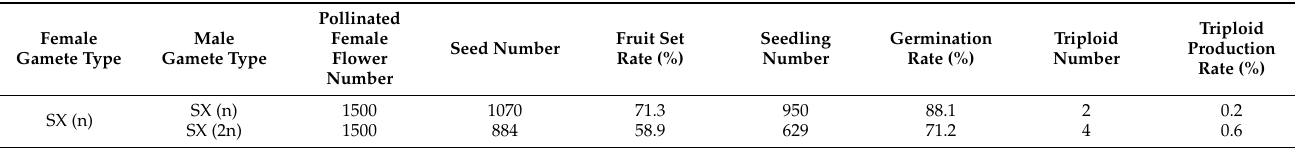
Figure 6. Detection of the ploidy level of the progenies of ‘Shixia’ longan generated from artificial pollination with 2n pollen. ( a ) Chromosome number of diploid root tip cells (2n = 2x = 30). ( b ) The ploidy level of diploid young leaves were detected by flow cytometry. ( c ) Chromosome number of triploid root tip cells (2n = 3x = 45). ( d ) The ploidy level of triploid young leaves was detected by flow cytometry. Scale bar = 10 µ m. Table 4. The production of triploids from artificial pollination with 2n